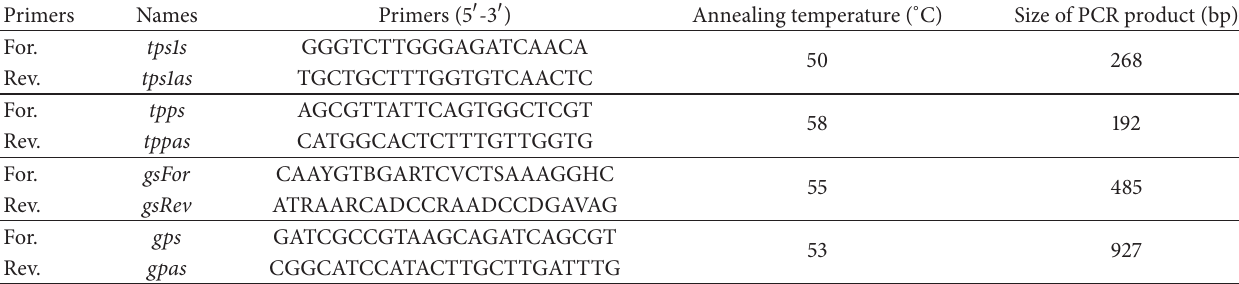
Table 1: Nucleotide sequences of primers for PCR amplification of genes encoding the enzymes for glycogen metabolism. Primers